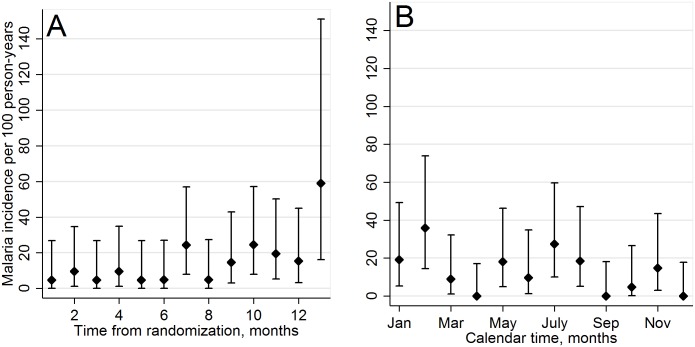
Incidence of malaria cases in CTX discontinuation arm.By study follow-up month (A) and by calendar month (B). Error bars represent the 95% confidence intervals.